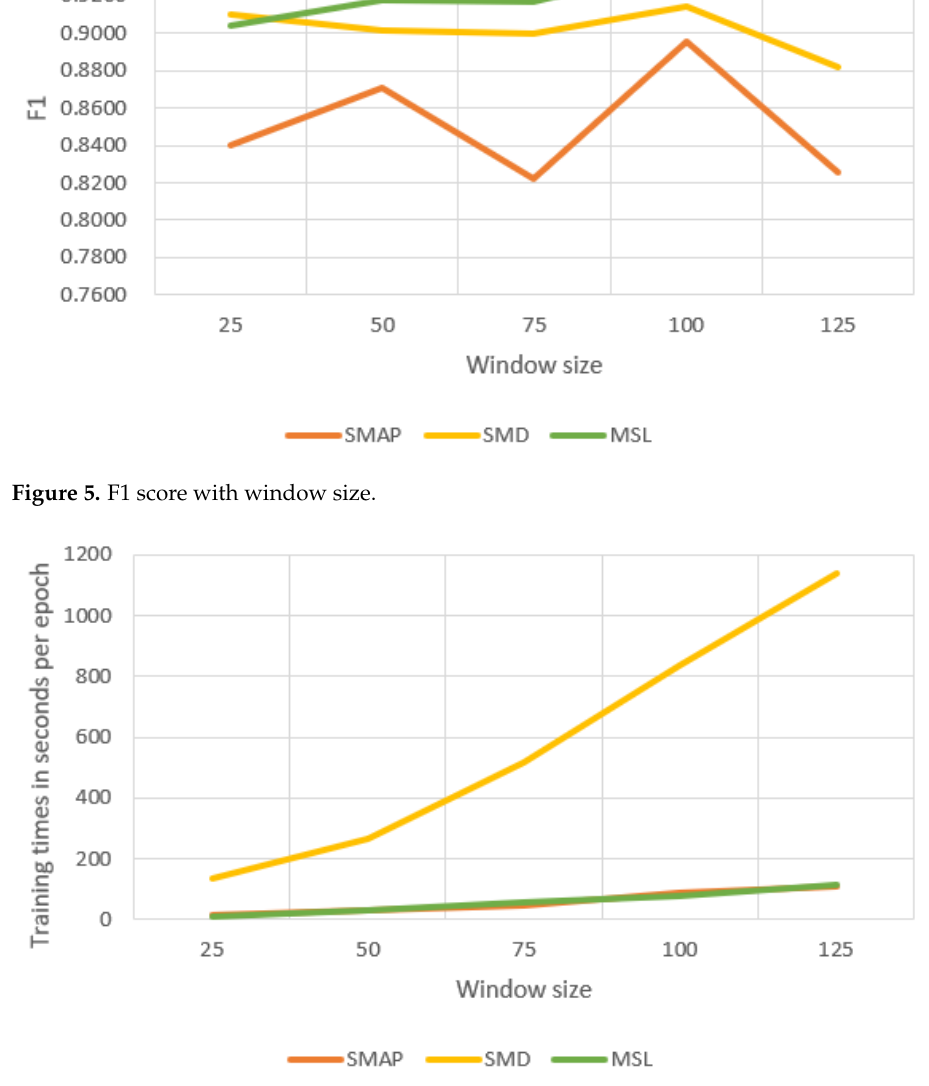
Figure 6. Training times with window